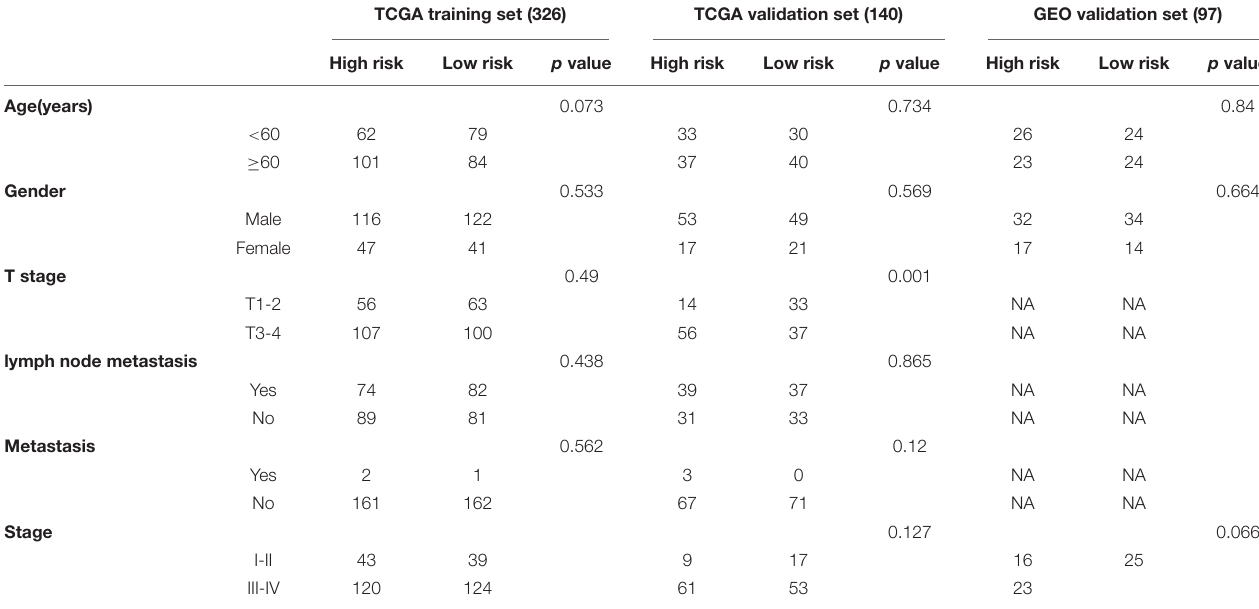
TABLE 1 | Clinical characteristics of patients with squamous cell carcinoma of the head and neck (HNSCC) enrolled in this study. TCGA training set